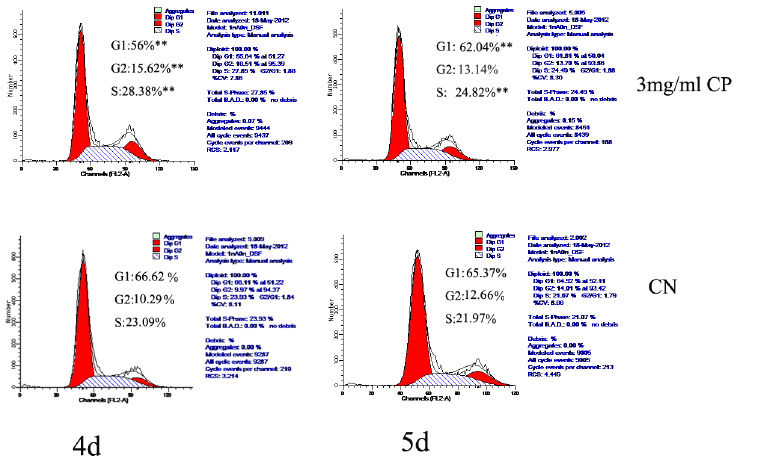
Figure 2. Alteration of the cell cycle distribution of MC3T3-E1 cells by bovine CP compound treatment. Cell cycle analyses were performed by FCM scanning. Representative histograms of MC3T3-E1 cells in the CP-treated and CN groups at 4–5 days are shown. Data are expressed as means 6 standard deviation (n=4). *p , 0.05, **p , 0.01, Significant difference from CN. CP: bovine collagen peptides compounds; CN: control.